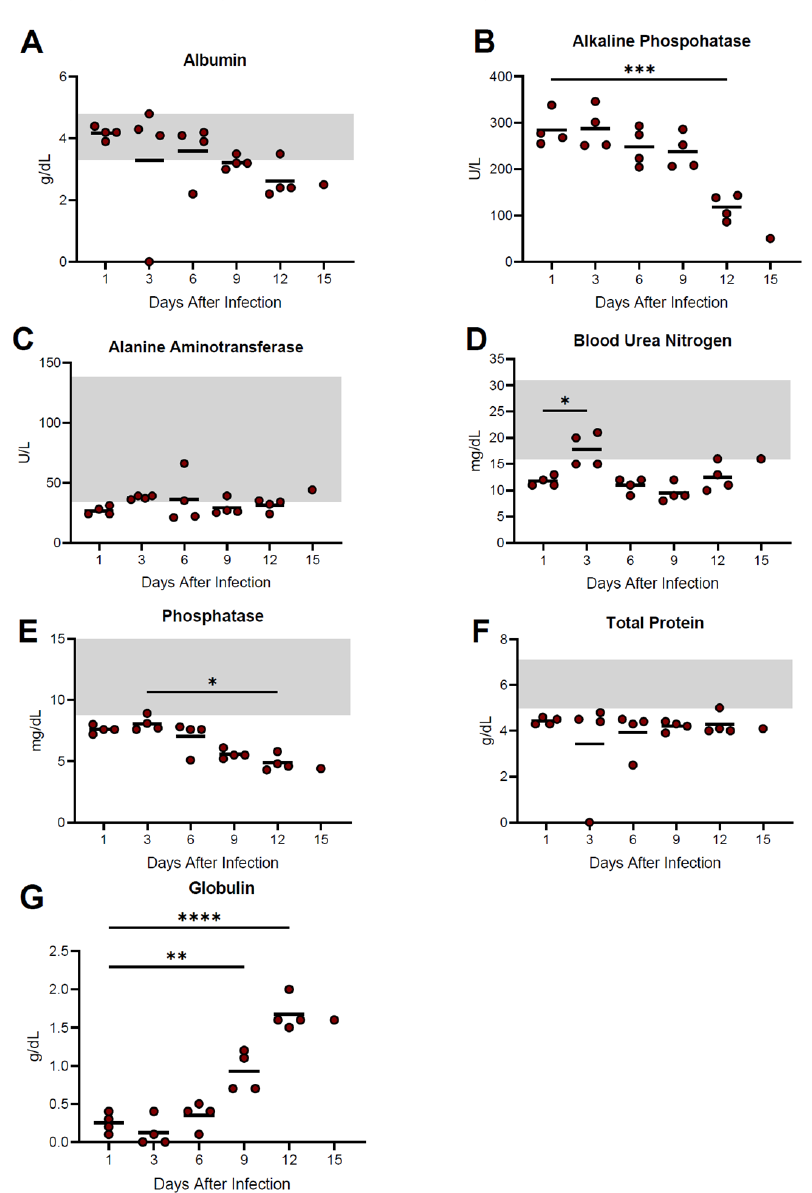
Figure 5. Temporal analysis of serum biochemistries from guinea pigs infected with NML-61/GPA. Twenty-four guinea pigs were inoculated with 100LD 50 of NML-61/GPA. Groups of four animals were euthanized at indicated days post-inoculation and analyzed for biochemical abnormalities. Shown are data for albumin ( A ), alkaline phosphatase ( B ), alanine aminotransferase ( C ), blood urea nitrogen ( D ), phosphataI ( E ), total protein ( F ), and globulin ( G ). Dots represent individual animal values, bar represents group averages. Where available, normal ranges are indicated by gray shad- ing (www.criver.com, accessed 8 March 2023). Significant differences where p < 0.05, <0.01, <0.001, and <0.0001 are indicated by *, **, ***, and **** respectively. Coagulation profiles demonstrated general increases in prothrombin time (PT), acti- vated partial thromboplastin time (aPTT) and Fibrinogen up until day 9 post-infection,